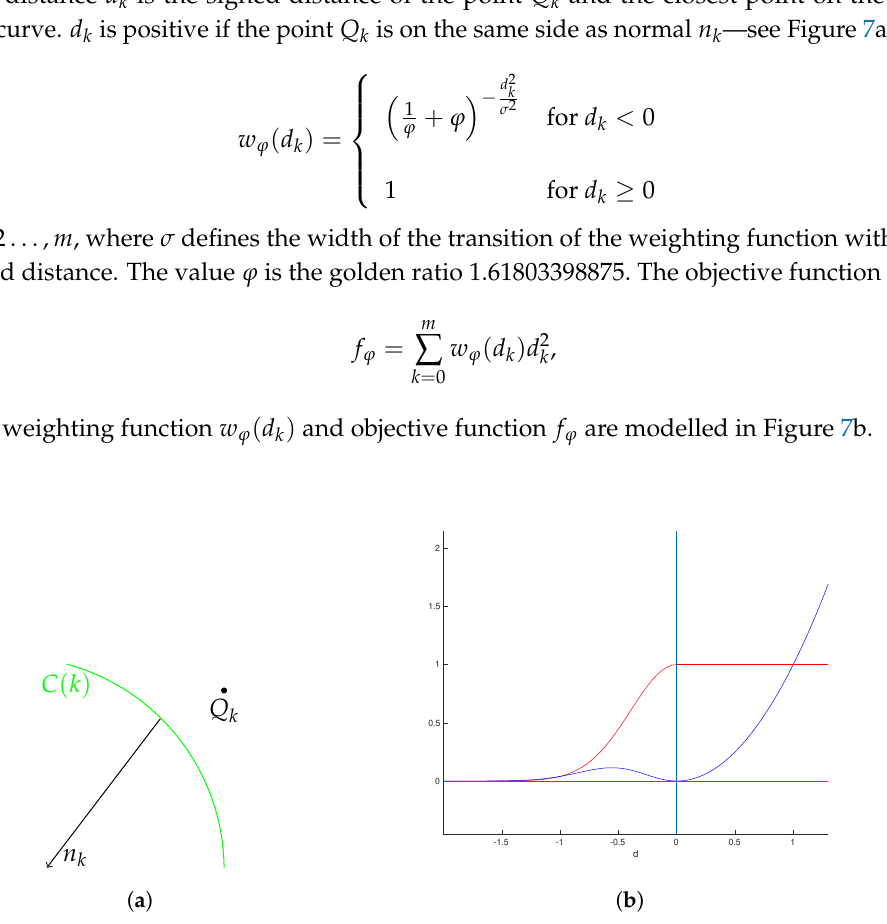
Figure 7. ( a ) Normal vector is on the opposite side of the point Q k , distance d k is negative, ( b ) the graphs of the functions w ϕ (red line) and f ϕ (blue